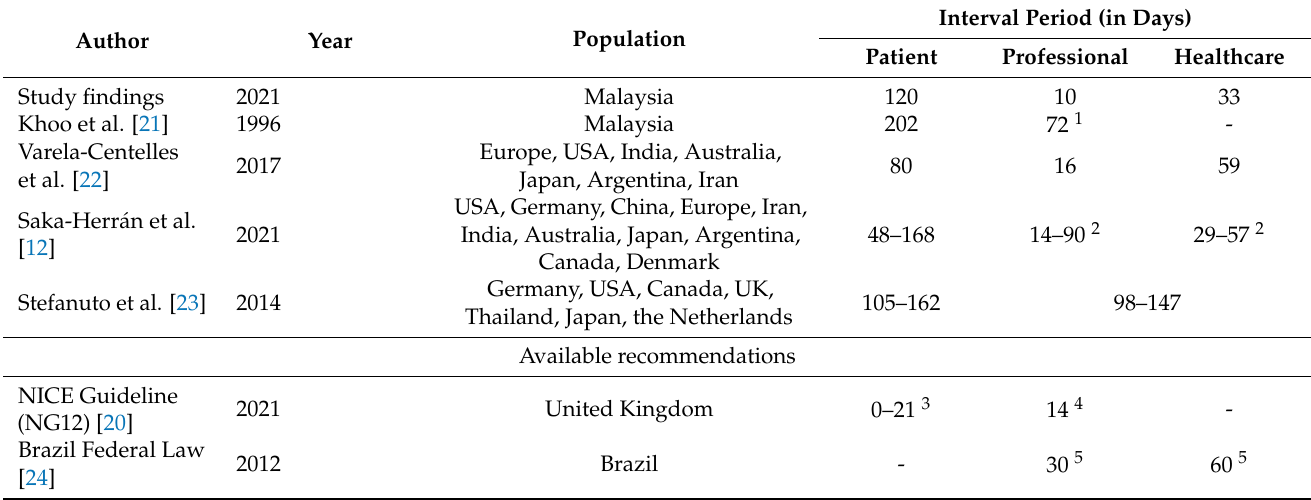
Table 4. Summary of time-to-treatment in literature and the recommended